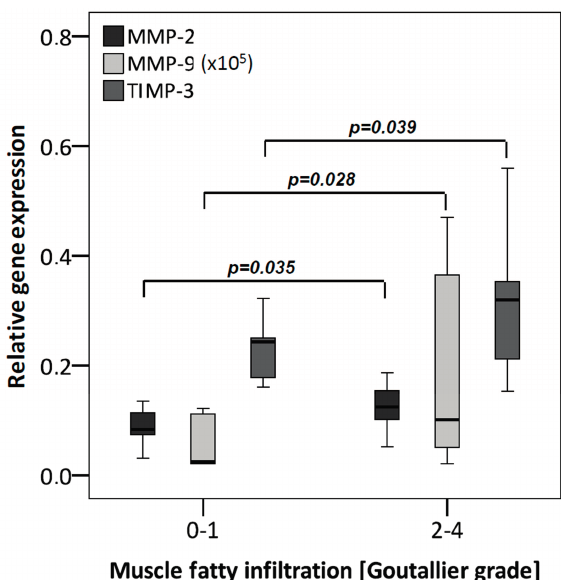
Figure 4. MMPs and TIMPs grouped according to the MFI (low MFI: Goutallier score 0–1 ( n = 10); high MFI: Goutallier score 2–4 ( n = 20)). qRT-PCR was performed to analyze gene expression. The box plot data represent the relative gene expression with 18S as reference gene using the Δ C t method with efficiency correction. In the high MFI group increasing gene expression for MMP-2, -9 and TIMP-3 occurred. To allow a visualization of all MMPs/TIMPs in one figure, MMP-9 values were multiplied by 10 5 . Tendon retraction was analyzed using two distinct groups: patients with the score of 0–1 ( n = 9) versus patients with the score of 2–3 ( n = 20). At mRNA and protein levels, no significant differences could be found between the two groups (data not shown). Nevertheless, tendon retraction showed mild correlation with protein secretion of TIMP-2 (r s = 0.407; p = 0.029) (Table 1). Groups for analysis of the tear size were set as follows: score 1–2 ( n = 12) and score 3–4 ( n = 18). At mRNA level, MMP-9 and -13 were significantly enhanced in TLCs from donors with bigger tear size, whereas MMP-10 showed significantly decreased expression rates. At protein level, MMP-1 and TIMP-1 were significantly higher expressed with bigger tear size (Figure 5). A mild correlation was found between tear size and mRNA values of MMP-9 (r s = 0.451; p = 0.012) and MMP-13 (r s = 0.460; p = 0.010) and a mild negative correlation with MMP-10 (r s = − 0.451; p = 0.012). At protein level tear size correlated mildly with MMP-1 (r s = 0.416; p = 0.022), TIMP-1 (r s = 0.526; p = 0.003), and TIMP-2 (r s = 0.413; p = 0.023) (Table